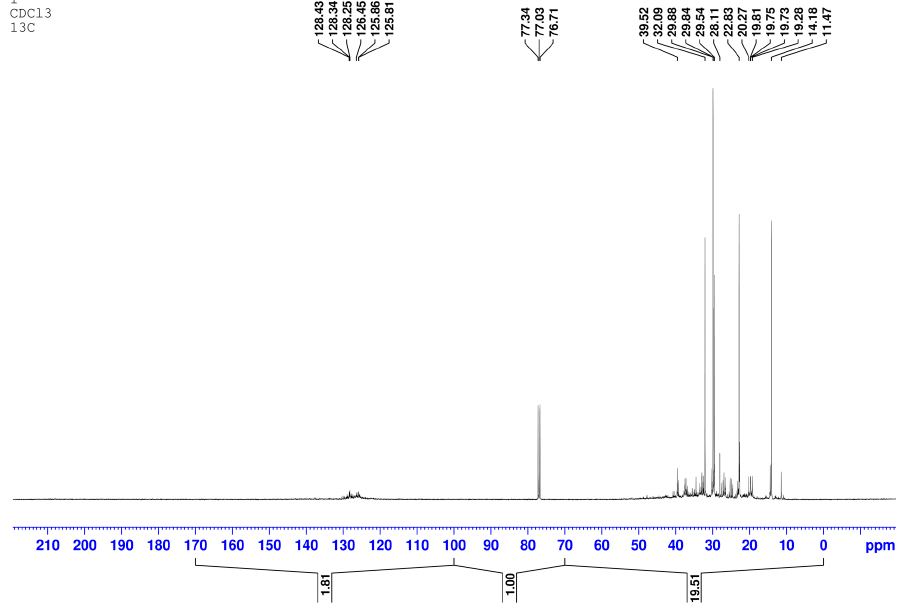
Figure 2. 13 C NMR spectra of the diesel fraction boiling at 200–350 ° С .